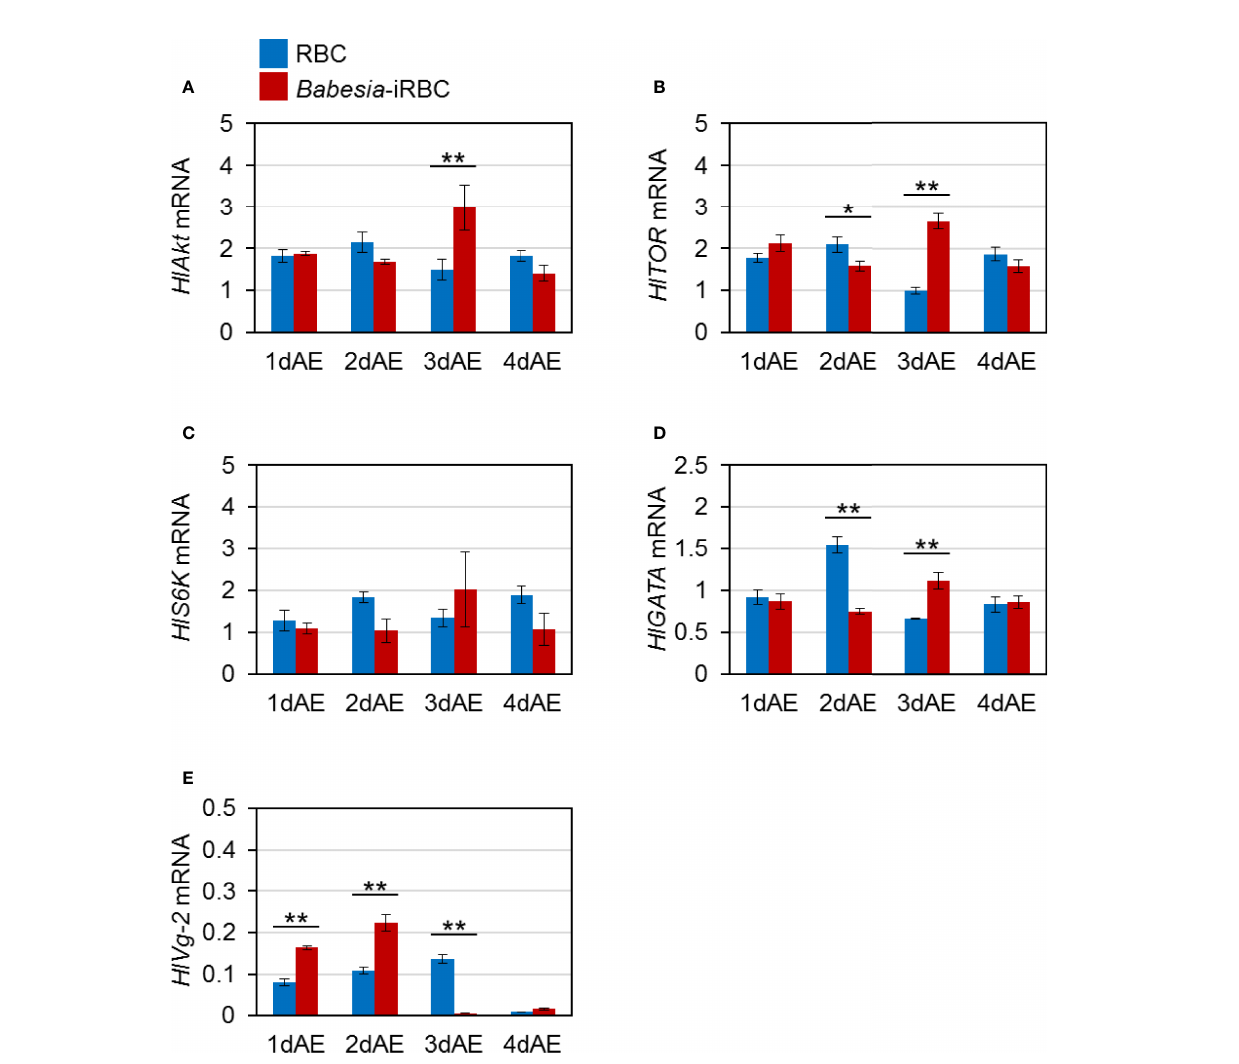
FIGURE 2 | mRNA expression analysis of (A) Akt ( HlAkt ), (B) target of rapamycin ( HlTOR ), (C) S6 kinase ( HlS6K ), (D) GATA ( HlGATA ), and (E) vitellogenin-2 ( HlVg-2 ) in the ovary after semiarti fi cial mouse skin membrane feeding with bovine red blood cells (RBC group) or with Babesia -infected bovine red blood cells ( Babesia -iRBC group). Total RNA was extracted from the ovary of engorged female ticks (n = 5) 1, 2, 3, and 4 days after engorgement (1dAE-4dAE). The relative expression levels were determined by real-time PCR as shown in Figure 1 . Data represent the mean ± SD of triplicated samples. Asterisks indicate the signi fi cant differences between the RBC and Babesia -iRBC groups (* P < 0.05, ** P < 0.01 using the Tukey – Kramer